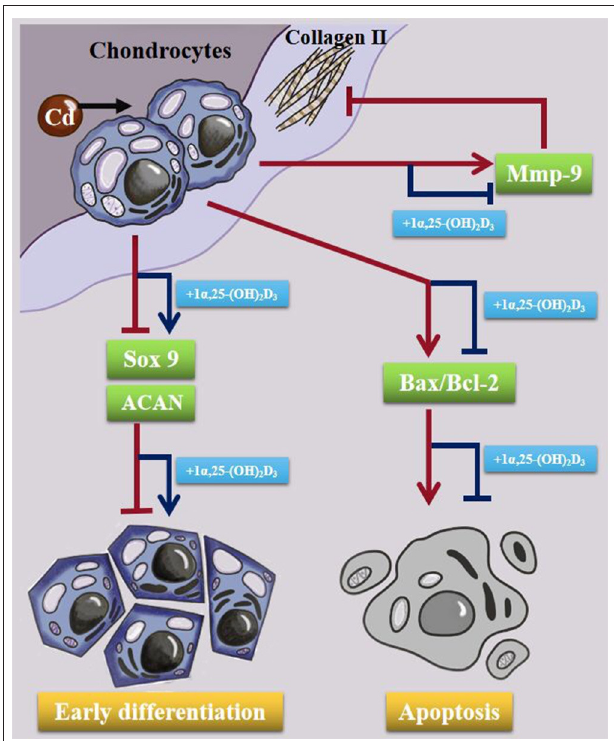
FIGURE 8 | Schematic diagram showing the effect of Cd in chondrocytes. Cd inhibited the expression of Sox9 and ACAN mRNA, eventual inhibition early differentiation in chondrocytes. Cd upregulated Bax/Bcl-2 expression and induced apoptosis in chondrocytes. Cd also promoted MMP-9 expression and COL2A1 degradation in the cells. 10 − 8 M 1 α ,25-(OH) 2 D 3 alleviated the toxic damage of Cd to